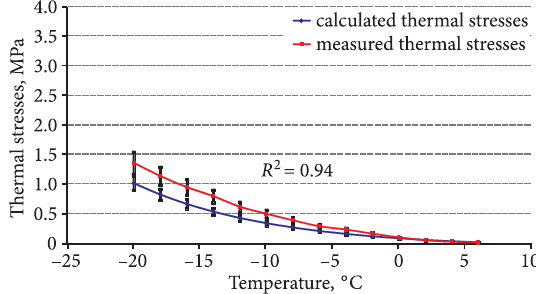
Fig. 8. Calculated and measured thermal stresses in asphalt concrete specimens containing 50/70 multigrade bitumen